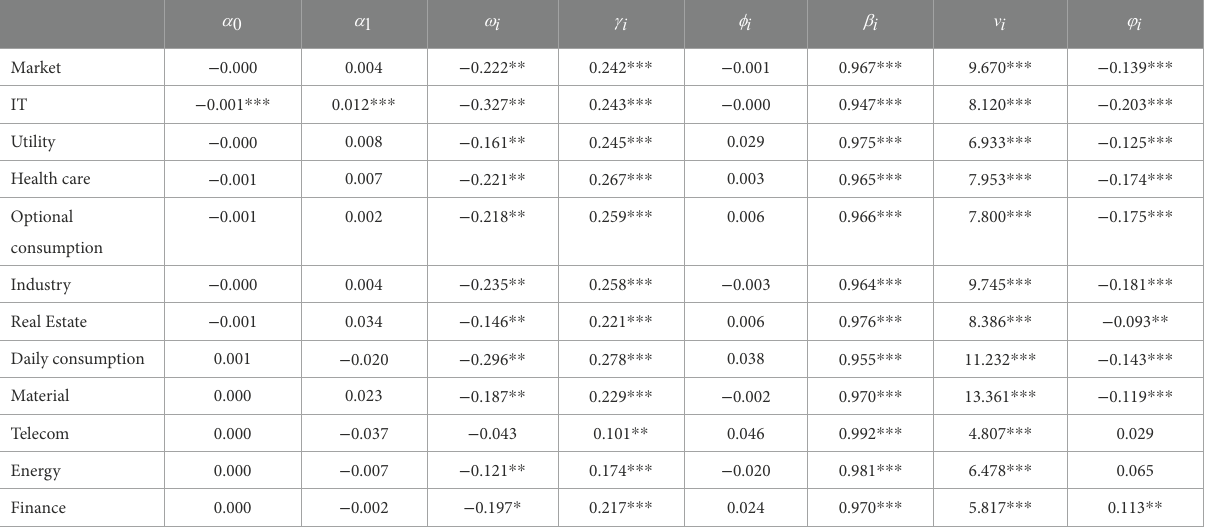
TABLE 3 Parameter estimation of the EGARCH model.